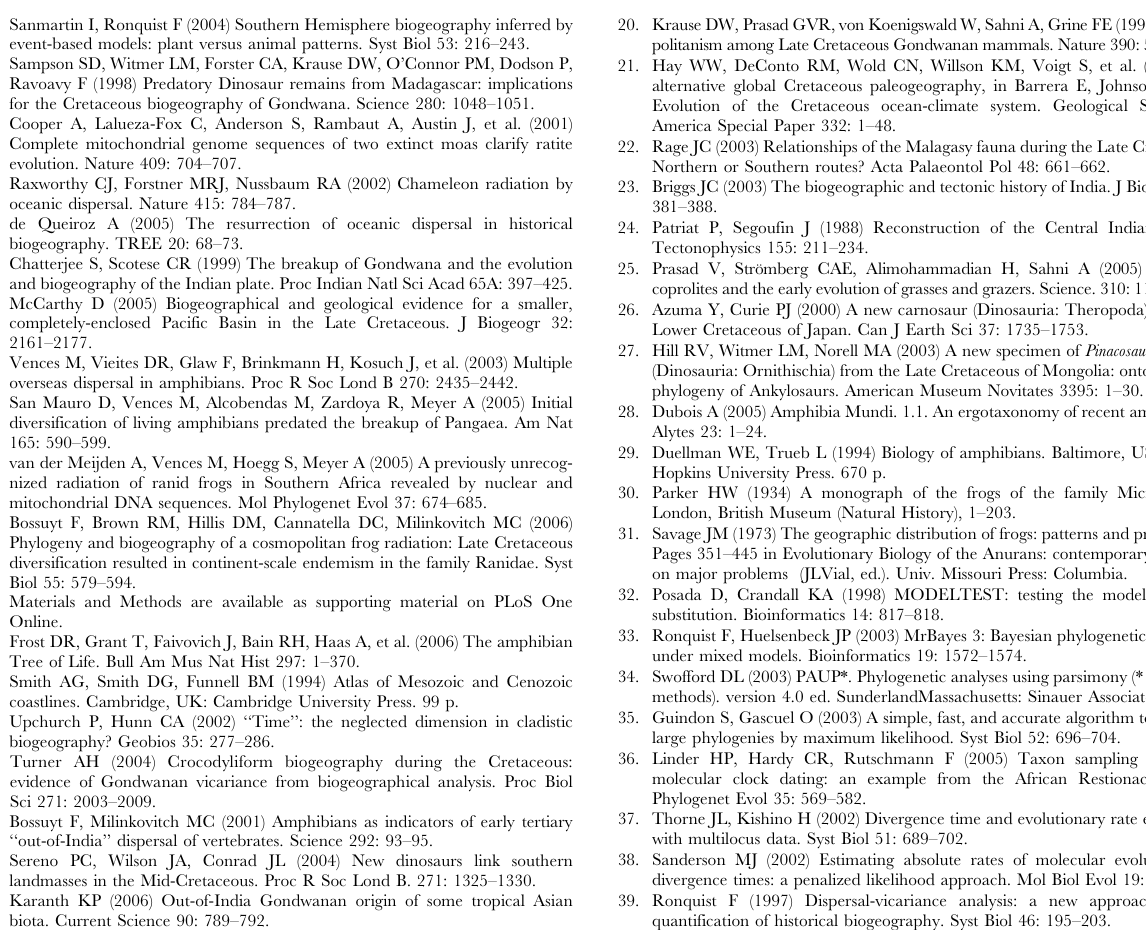
analysis; Vicariance (2) represents the analysis with the three India-Eurasia splits constrained as India-Madagascar. The two DIVA reconstructions represent the actual distribution of the frogs, while the associated continental break-up is the presumed geological unit at the moment of break-up, based on our divergence times. Node numbers and colors associated with break-up correspond with figure 2. Afr= Africa, Ind= India, SAm = South America, Mad =Madagascar, Aus= Australia-New Guinea, Eur =Eurasia, KP = Kerguelen